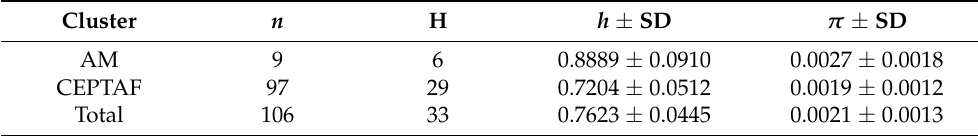
Table 2. Summary of concatenated mtDNA diversity parameters estimated for each cluster